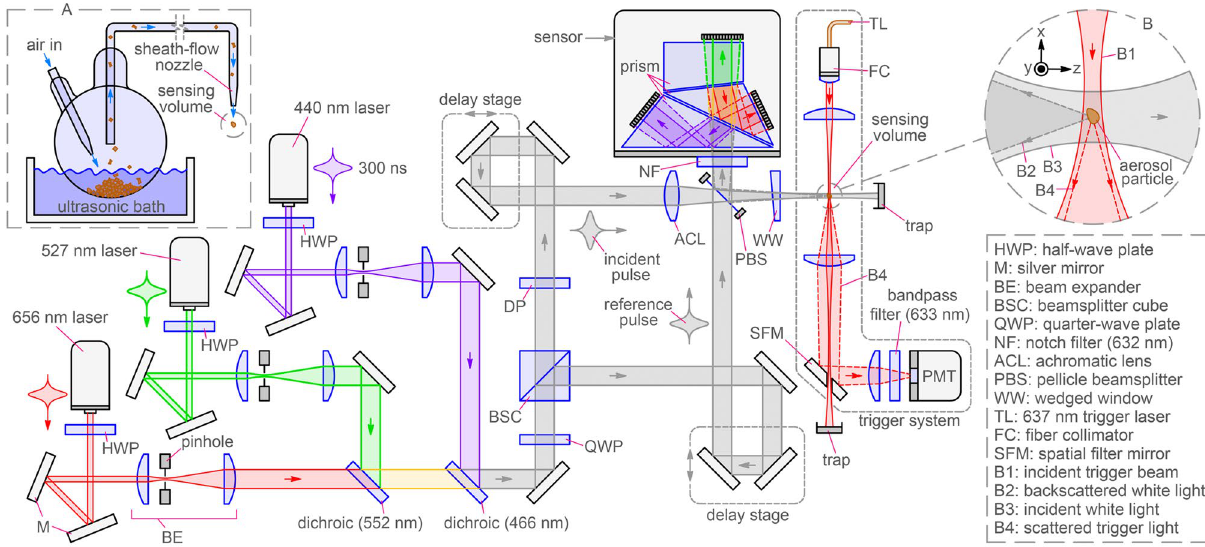
Figure 6. Optical design used to record color backscatter-holograms of free-flowing aerosol particles. Pulsed red ( (cid:31) r = 656 nm), green ( (cid:31) g = 527 nm), and blue ( (cid:31) b = 440 nm) laser beams are combined into a white beam, which is split by the BSC to form incident and reference beams. A Mach-Zehender configuration is used to interfere the light backscattered by an aerosol particle in the sensing volume with the reference beam at the sensor. The particles are delivered to the sensing volume via a sheath-flow nozzle fed by an aerosol generator, shown in ( A ). An optical trigger system senses when a particle is present in the volume and supplies a signal to activate emission of a 300 ns pulse from each laser and begins the sensor exposure. This is achieved by illuminating the sensing volume by a CW trigger beam (B1) in inset ( B ), which scatteres from any aerosol particle present. The scattered light (B4) is separated from unscattered light by the mirror SFM and then sensed by the PMT to create the trigger signal. The coordinate system is shown in inset ( B ) where the incident (white) holography beam (B3) defines the positive z -axis and the backscattered light in ( B ) is labeled